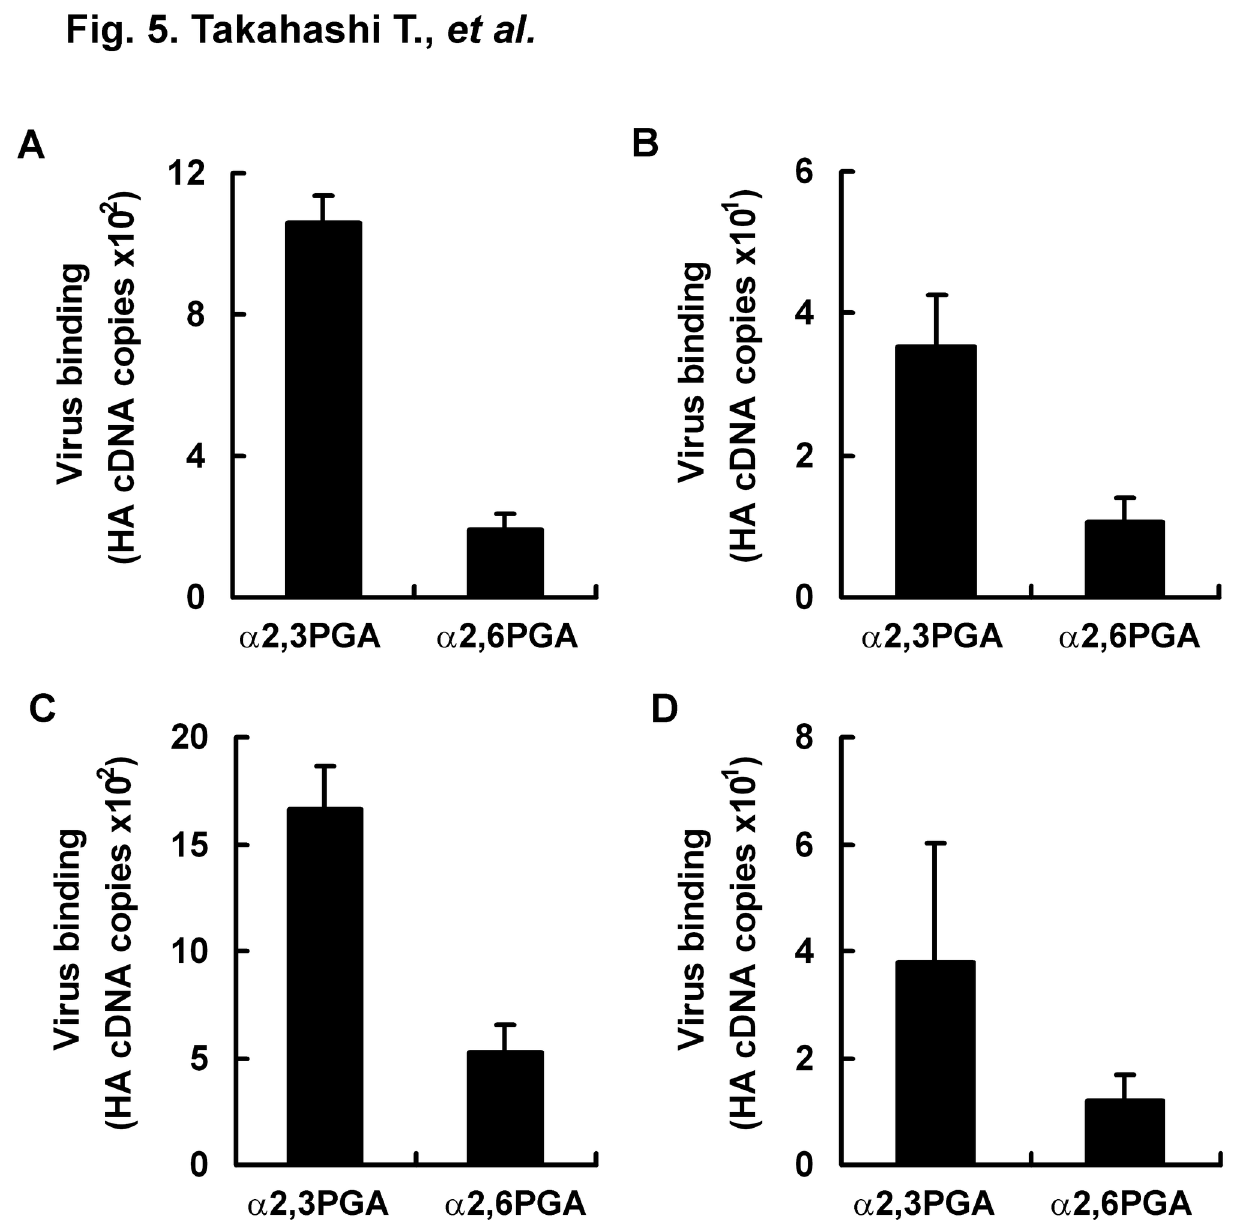
Figure 5. Direct detection of receptor binding specificity of HPAIs in swabs by real-time PCR. A microplate was immobilized with 200 ng/well of α2,3PGA or α2,6PGA and then blocked with 1% lipid-free BSA in PBS at 4 °C overnight. Trachea swabs (A and C) and cloaca swabs (B and D) were obtained from chickens infected with HPAIs CS10 (A and B) and CM11 (C and D). Swabs were suspended in equal amounts of PBS. The swab suspensions (50 μl/well) were incubated for 2 h at 4 °C on microplates that were immobilized with α2,3PGA or α2,6PGA. Viral RNAs of viruses bound to α2,3PGA or α2,6PGA were extracted. Viruses that bound to α2,3PGA or α2,6PGA were measured as copy number of HA cDNA by using real-time PCR. Each value (S.E.) is the average from three independent experiments. Directly from swabs obtained from HPAI-infected chickens, this assay indicated that HPAIs CS10 and CM11 had the general property of receptor binding specificity of avian IAV (preferential binding to Neu5Acα2,3Gal).